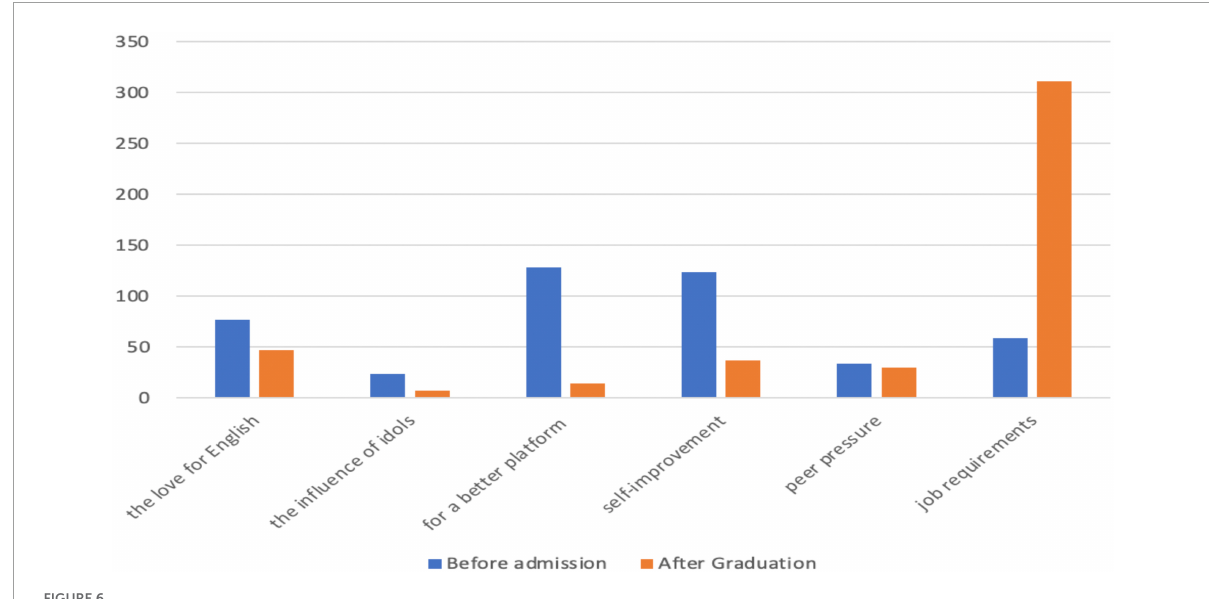
FIGURE6 Comparison between the initial motivation and present